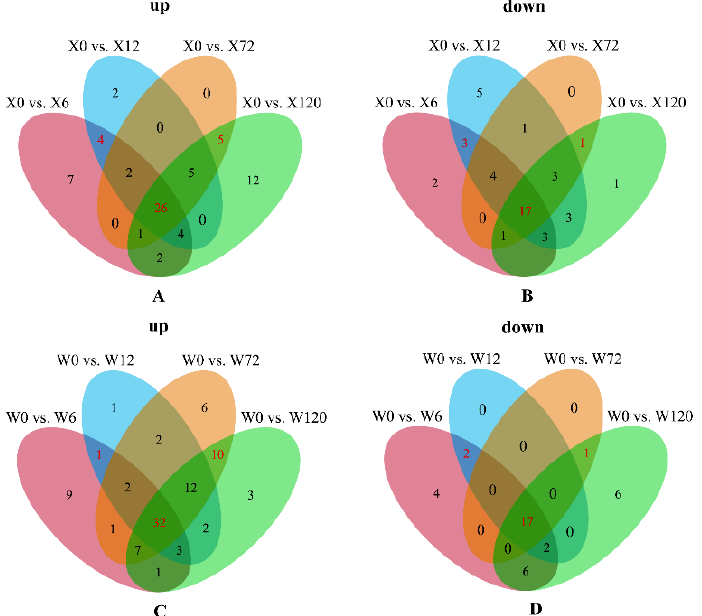
Figure 6. Venn diagram showing the number of up-regulated ( A ) for drought-tolerant genotype (X) and ( C ) for drought-sensitive genotype (W) and down- regulated ( B ) for drought-tolerant genotype (X) and ( D ) for drought-sensitive genotype (W) DMs between drought-tolerant genotype (X) and drought-sensitive genotype (W).